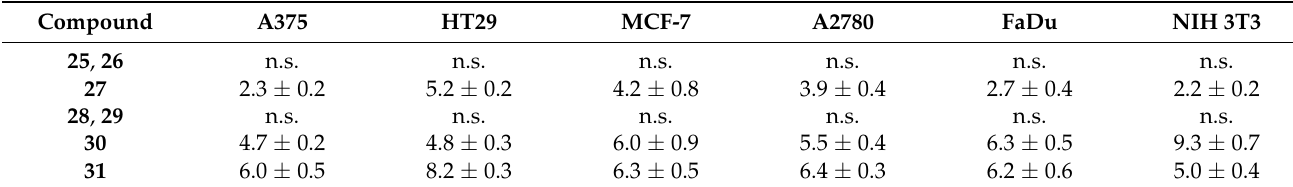
Table 3. (EC 50 in µ M from SRB) of diazabicyclononanes derived amides 25 – 31 . The values are averaged from three independent experiments performed each in triplicate, confidence interval CI = 95%; mean ± standard mean error); n.s. not